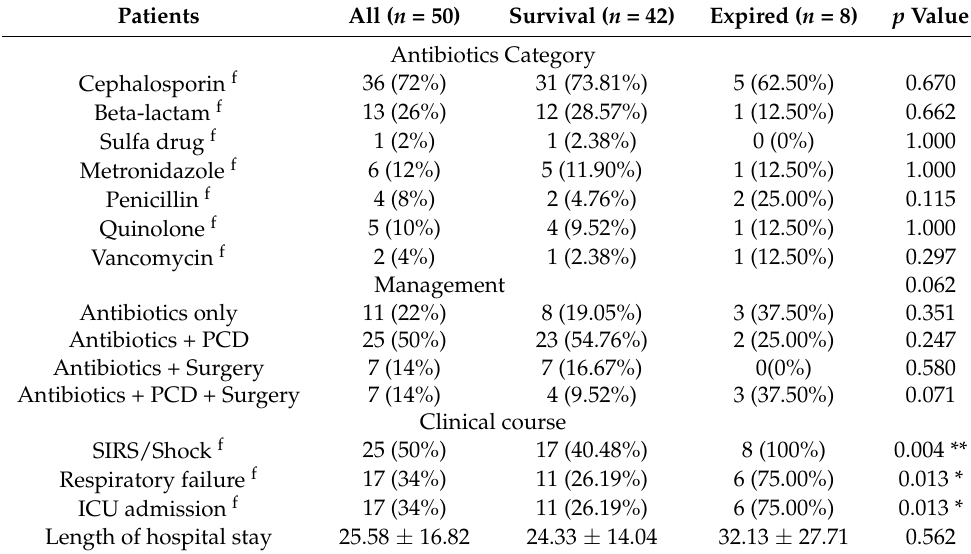
Table 5. Antibiotics, management, and clinical course of